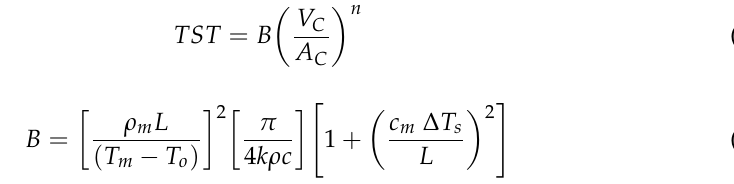
Table 2. Thermophysical properties of Al-7.5Si aluminium alloy and sand, and metallic moulds. Sand Mould Metallic Mould Melting temperature of the liquid (K), T m 913 Superheat (K), ∆ T s 80 Temperature of the mould (in K), T o 288 543 Latent heat of fusion (J kg − 1 ), L 4.45 × 10 5 [31] Thermal conductivity of the mould (Wm − 1 K − 1 ), k 1.4 [32] 19.54 [33,34] Density of the mould (kg m − 3 ), ρ 1570 [32] 7800 [33,34] Specific heat of the mould (J kg − 1 K − 1 ), C 1153 [32] 522 [33,34] Density of the metal (kg m − 3 ), ρ m 2.76 × 10 3 [35] Specific heat of the metal (J kg − 1 K − 1 ), C